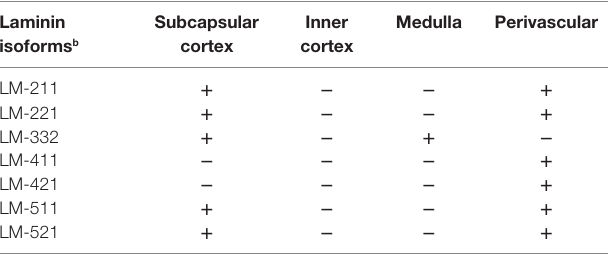
TABLe 2 | In situ intrathymic expression of laminin isoforms a